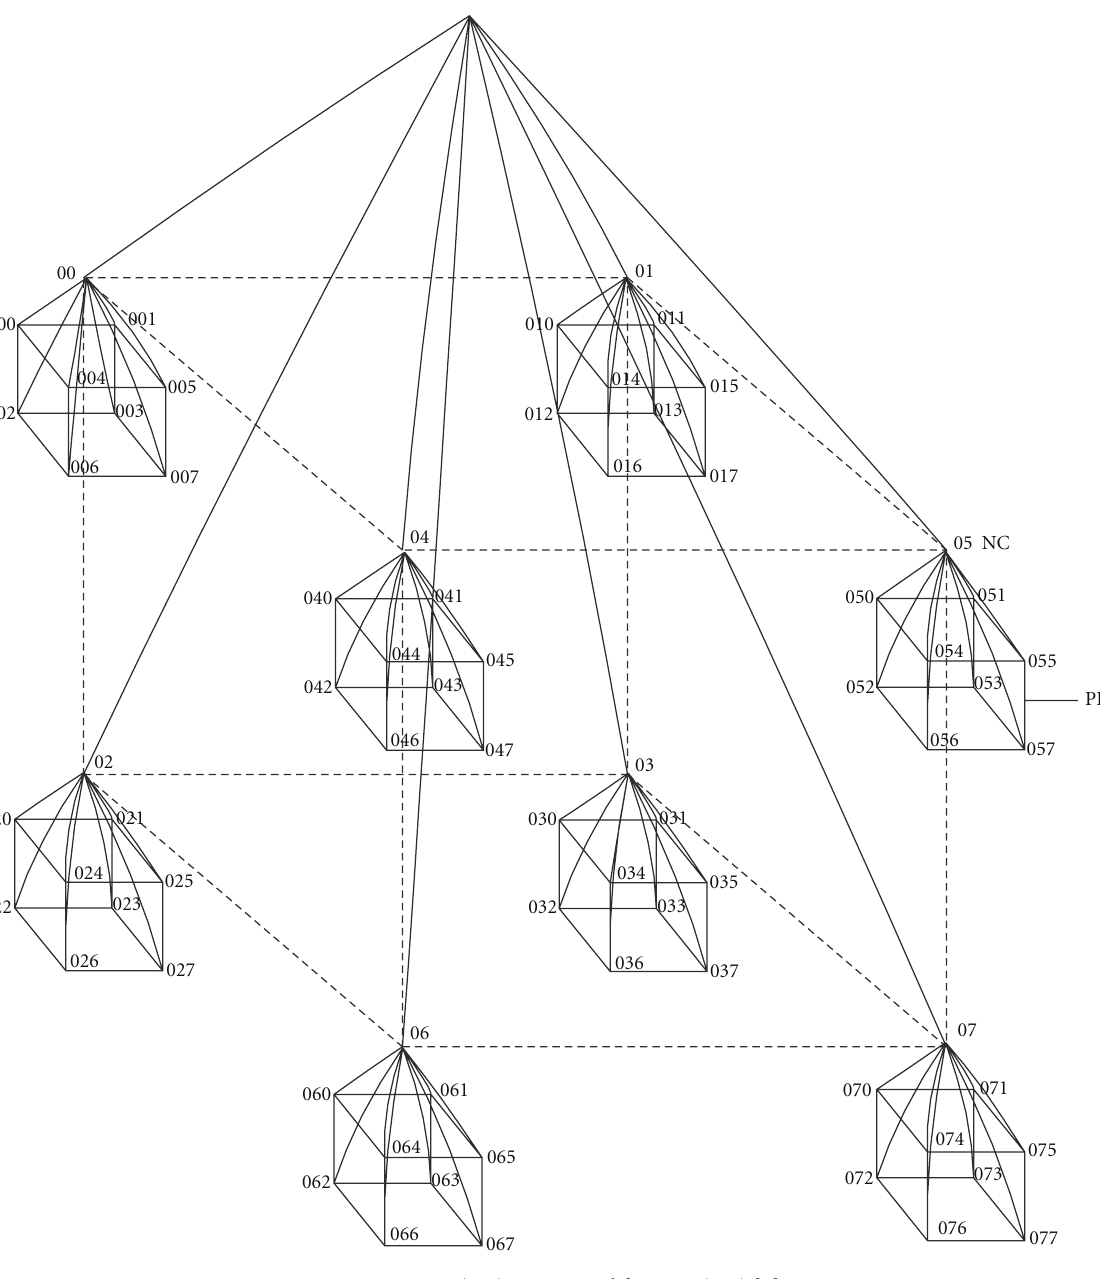
Figure 5: An EH(3,2) constructed from EH(3,1) [6].